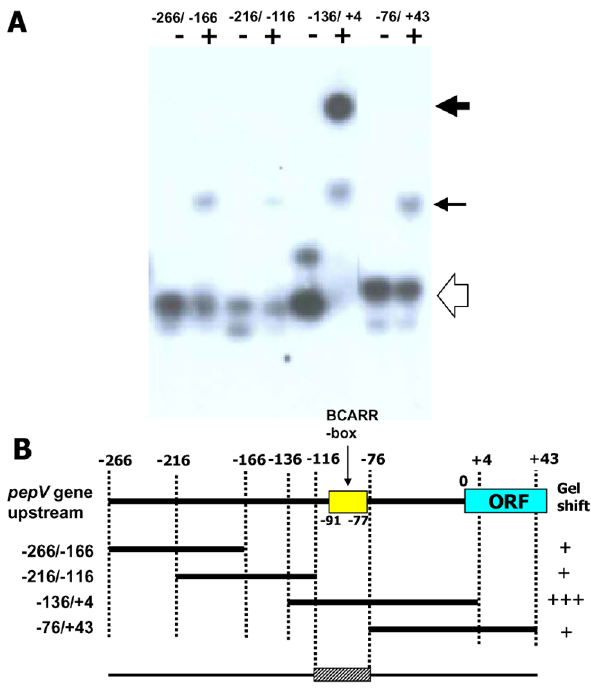
Figure 5. Electrophoresis mobility shift assay with various DNA fragments of the region upstream of the pepV . Mobility shift assay with or without 2.3 m M BCARR protein and 10 mM BCAAs (A). Each 2,500 cpm of 32 P labeled DNA fragment (0.3 ng) was incubated as described in Materials and Methods. Protein-DNA complexes were analyzed by 10% polyacrylamide gel electrophoresis. The 32 P signals in the gel were detected by exposure to X-ray film. The position of the shifted bands is indicated in the right margin by arrows (weak shift indicated by a small arrow, and a significant shift by a big arrow; the origin is indicated by the open arrow). DNA fragments used in the above experiment and the results of the EMSA are summarized in (B). Nucleotide positions are relative to the start codon. BCARR-Box indicates the predicted BCARR binding motif by MEME analysis. ORF shows the open reading frame of the pepV gene. The intensity of the shifted bands is indicated by + (slight probe shifted) to +++ (all probes shifted).